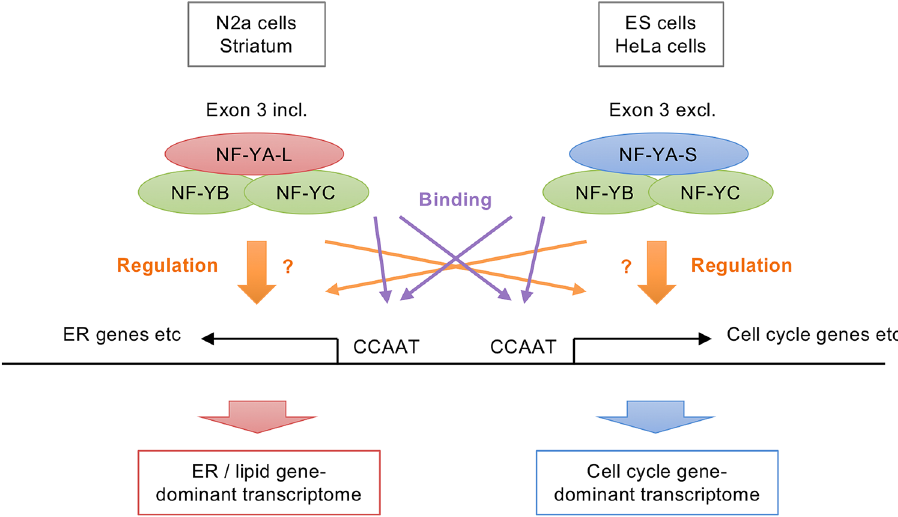
Figure 7. Schematic model of two distinct transcriptomes modulated by NF-Y complex containing different NF-YA splicing isoforms. Gene expression profiling in N2a and striatal cells suggests that neuronal cells contain the transcriptome in which ER/lipid genes were dominantly modulated by NF-Y. This contrasts with the NF-Y- transcriptome in HeLa and ES cells in which cell cycle/mitochondria genes were preferentially modulated. RNA- seq and ChIP data analyses suggest that NF-YA splicing alteration rather than DNA-binding preference could be involved in these cell type-specific